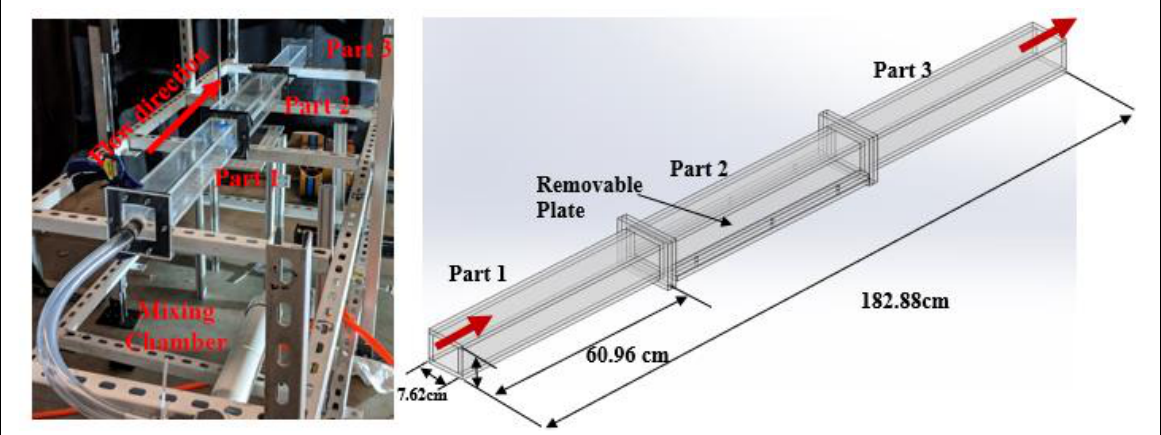
Figure 1. Test channel and Computer-Assisted Drawing (CAD) of the